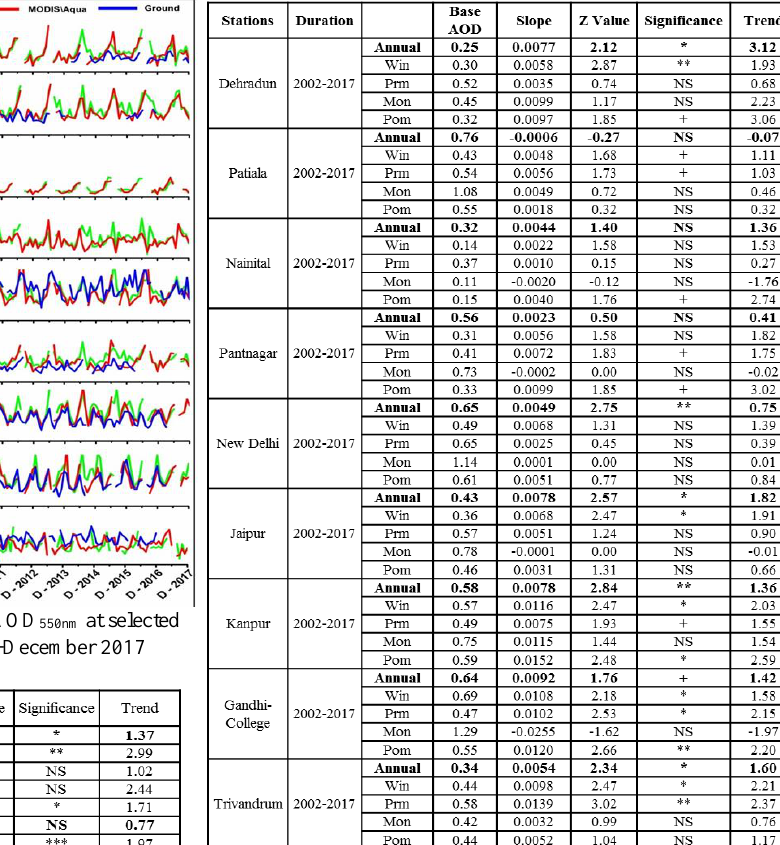
Table 3. Statistics of MODIS Aqua AOD 550nm at different locations over India for the time period of 2002–2017. Trend analysis was done with non-parametric Mann-Kendall